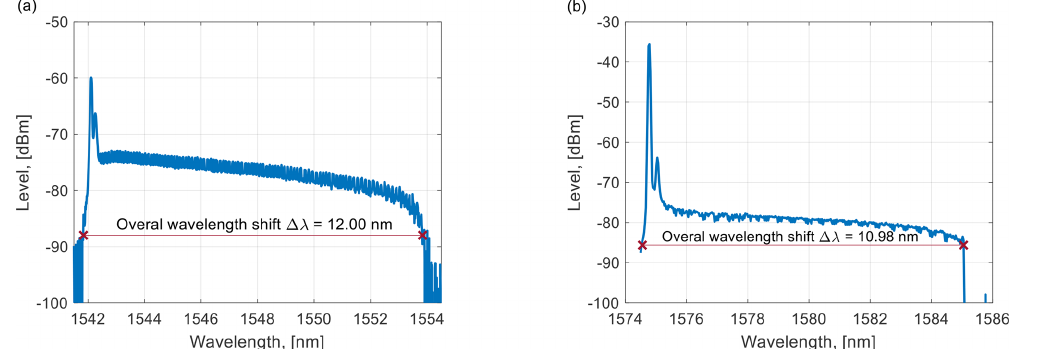
Figure 7. Emission spectrum of the swept VCSEL measured with an OSA for (a) VL-1544 by a pump current of i B = 1 and i P = 28mA and (b) VL-1577 by a pump current of i B = 1 and i P = 20mA at the repetition rate of 50Hz and pulse width of